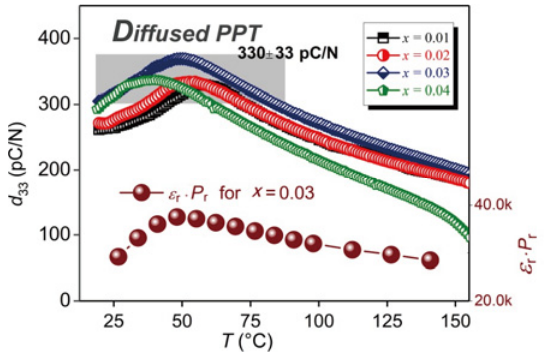
Fig. 7 Temperature stability of d 33 of LKNNS  EuNZ  x BZ